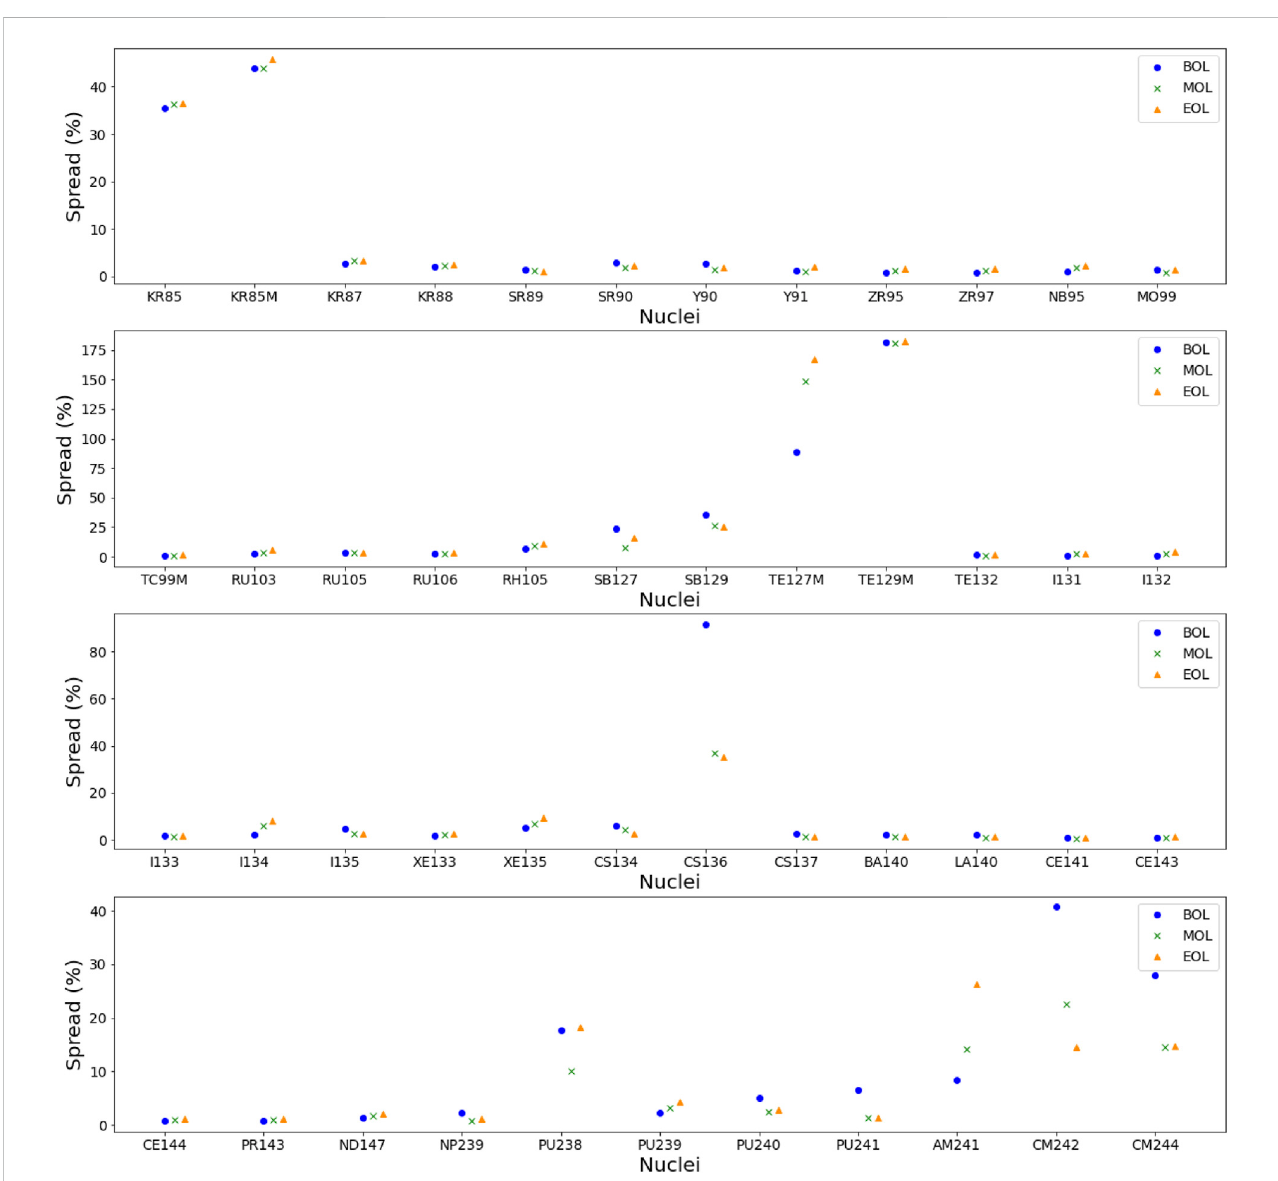
Spread on the assembly nuclide inventory due to the use of various nuclear data libraries, for three burnup values, for UO 2